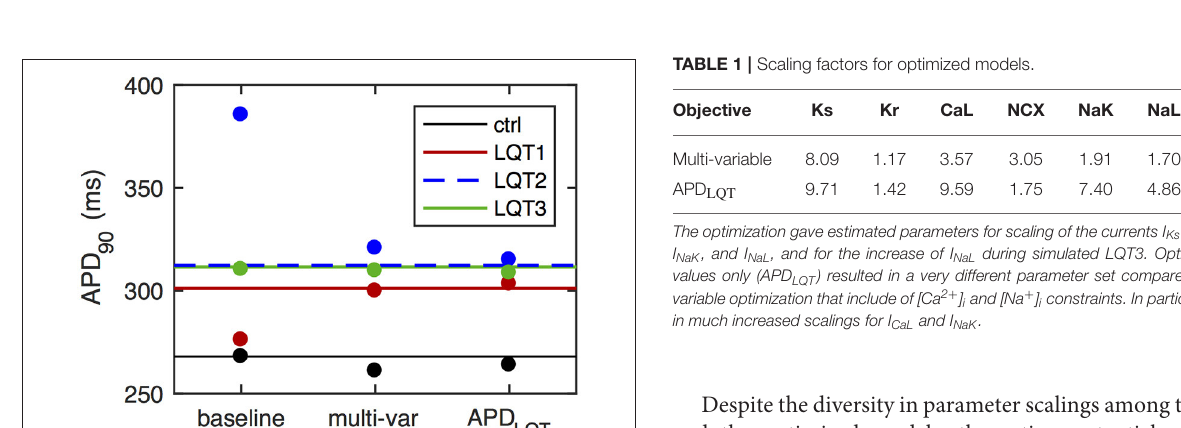
FIGURE 1 | Sensitivity of baseline ORd model to select conductances. (A) The APD of the baseline model has a strong sensitivity to the conductance of I Kr . (B) The calcium transient (quantified here as systolic [Ca 2 + ] i ) depends sensitively on G CaL , G NCX , and G NaK . (C) The level of [Na + ] i depends mainly on G NaK . Conductances were varied by ± 20% (light blue/red) and ± 50% (dark blue/red) of baseline values.